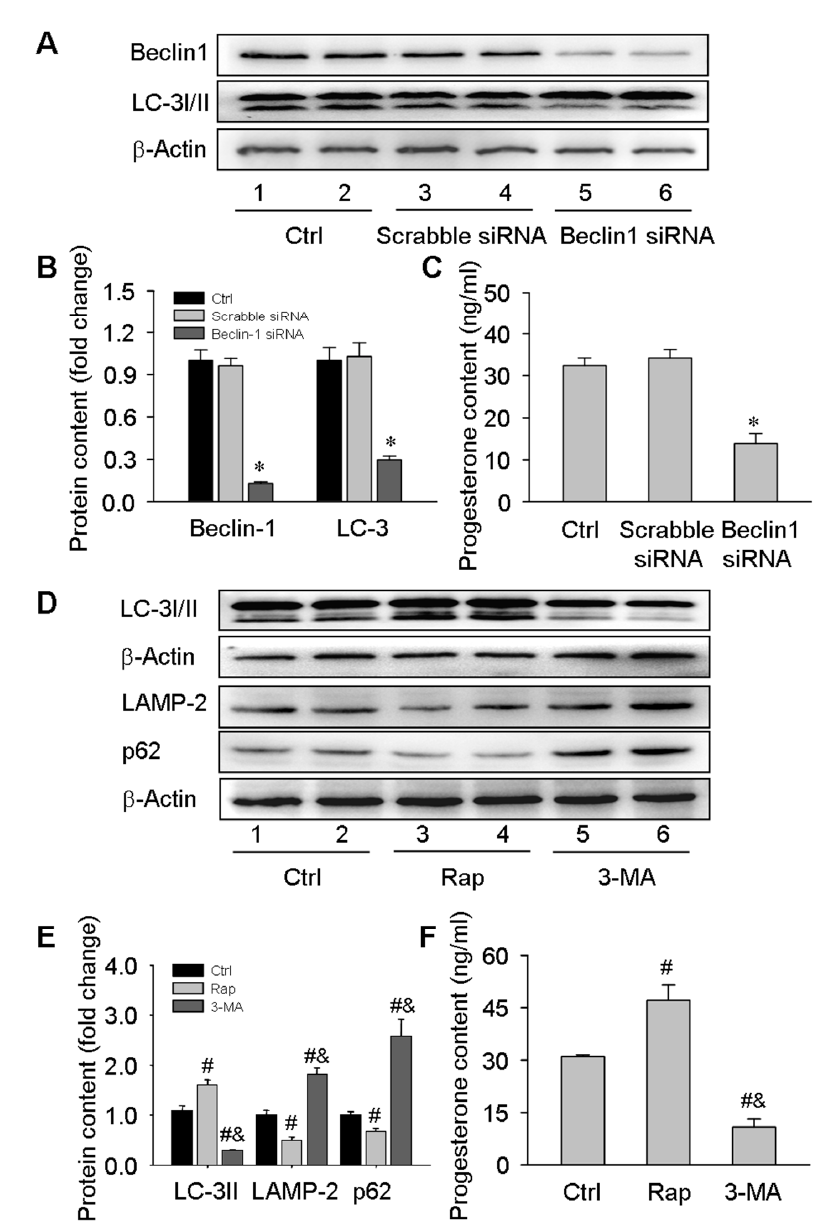
Figure 5. Contribution of autophagy to progesterone production in luteal cells cultured in vitro. Luteal cells were isolated from rat ovaries on day 16 of pregnancy and then cultured with Beclin1 siRNA transfection or Rap/3-MA treatment: ( A ) representative western blot analyses depicting the protein levels of Beclin1 and LC-3 in luteal cells transfected with scrabble or Beclin1 siRNA. The luteal cells were plated on 6-well plates one day before transfection, and the transfection was performed at a 70% confluence. The protein contents were detected 48 h after transfection; ( B ): summarized intensities of Beclin1 and LC-3II blots normalized to the control; ( C ) serum progesterone levels; ( D ) representative western blot analyses depicting the protein levels of LC-3I/II, LAMP-2, and p62 in luteal cells treated with Rap or 3-MA. The luteal cells were plated on 6-well plates one day before treatment. The cells were remained as untreated controls or treated with Rap or 3-MA for 24 h; ( E ) summarized intensities of LC-3II,LAMP-2, and p62 blots normalized to the control; ( F ) serum progesterone levels. Each value represents the mean ± SE, n = 6. ANOVA was used to analyze the data.